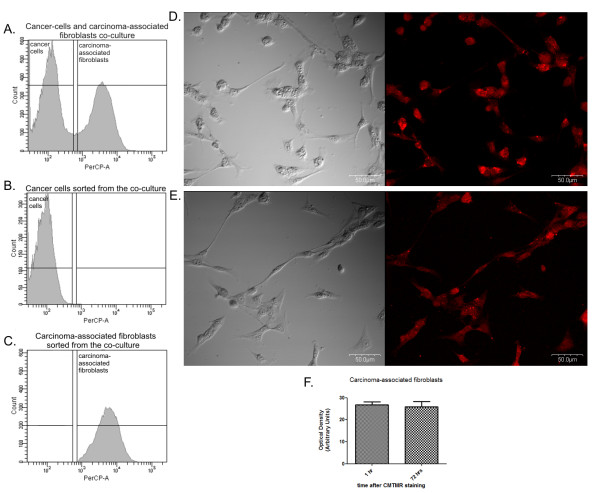
Histogram and pictures of unstained cancer cells and stained CAFs. A. Representative histogram and sorting gates of unstained cancer cells and CMTMR-stained carcinoma-associated fibroblasts (CAFs) grown as the co-culture for 72 hrs. B. Histogram of cancer cells sorted from co-culture showing only CMTMR-negative cells. C. Histogram of CAFs sorted from co-culture showing only CMTMR-positive cells. D. and E. Representative pictures obtained using confocal microscopy showing red-colored stained cytoplasm (CMTMR staining) of CAFs growing as a single culture for 1 hr and 72 hrs, respectively. The imaging of cells was performed on confocal laser scanning microscope FV-500 system (Olympus Optical Co, Germany). The cells were examined using the Fluoview program (Olympus Optical Co., Germany). F. The graph showing mean optical density of the red (reflecting CMTMR staining) in CAFs at 1 hr and 72 hrs after staining. For statistical purposes the t-test has been applied (Graph Pad 5.0), no significant difference has been observed between these two values.